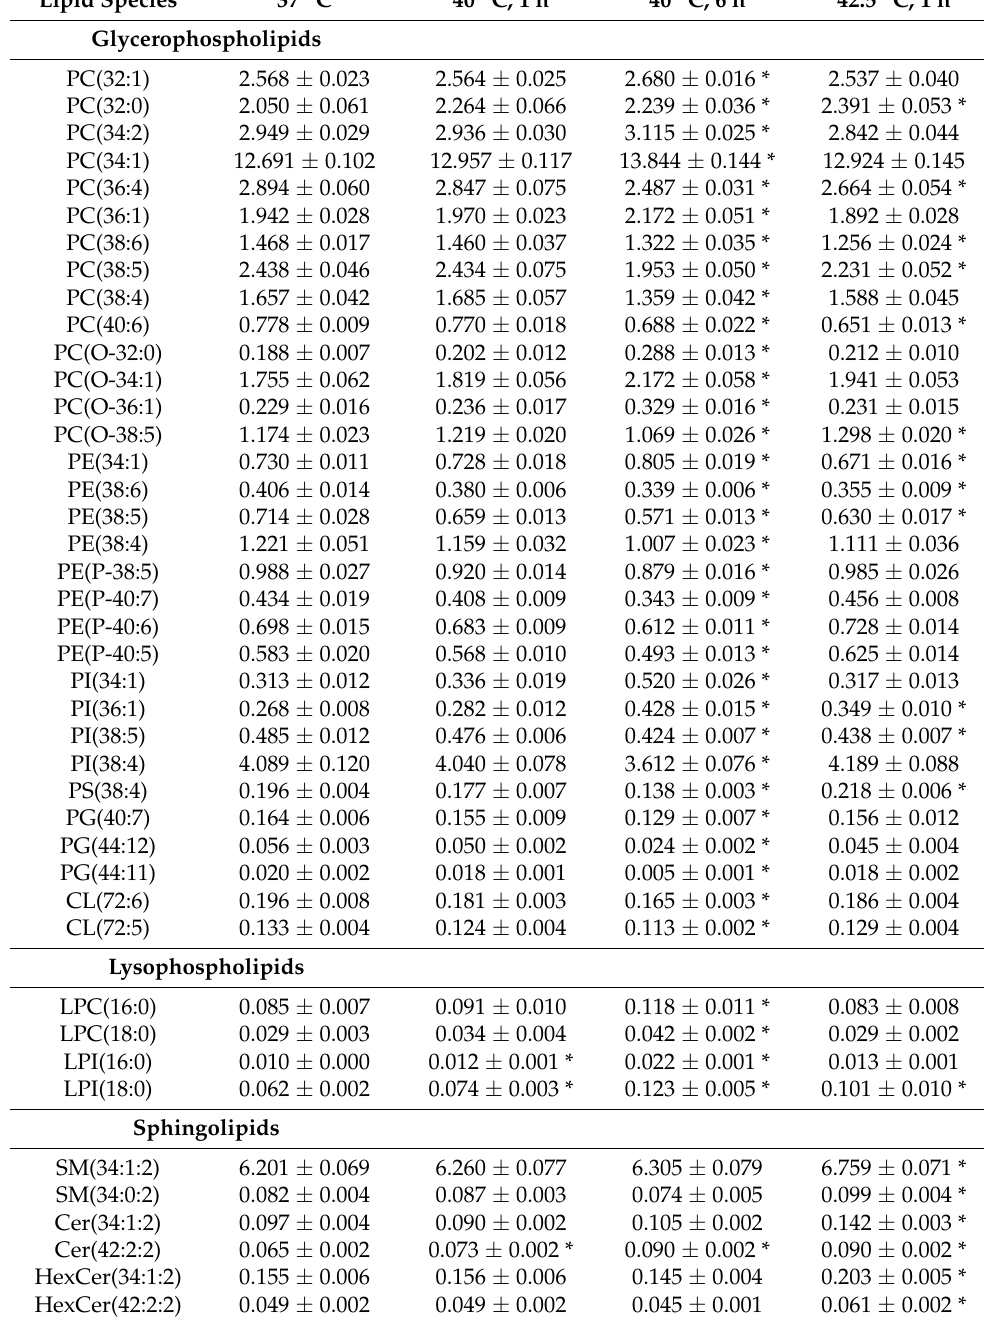
Table 2. Selected, significantly changing membrane lipid